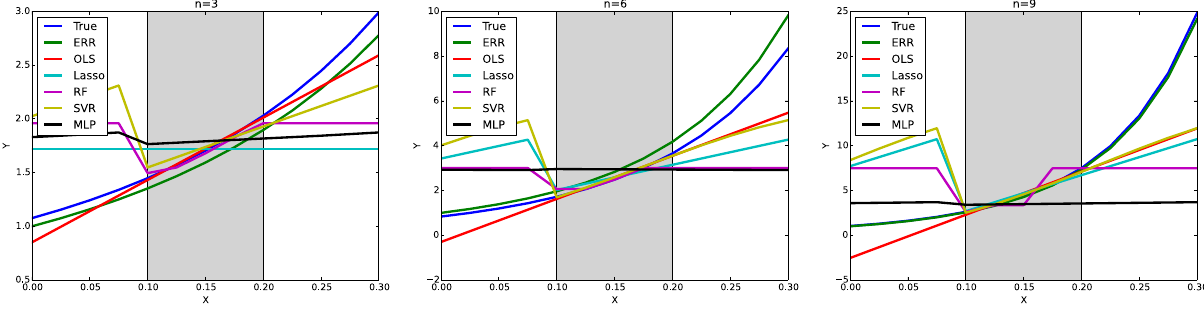
Figure 2. Prediction results of the regressors in the simulated datasets. Each plot corresponds to a different coefficient, and they are n = 3 (left), n = 6 (center), and n = 9 (right). All the regressors except for ERR show poor extrapolation abilities.